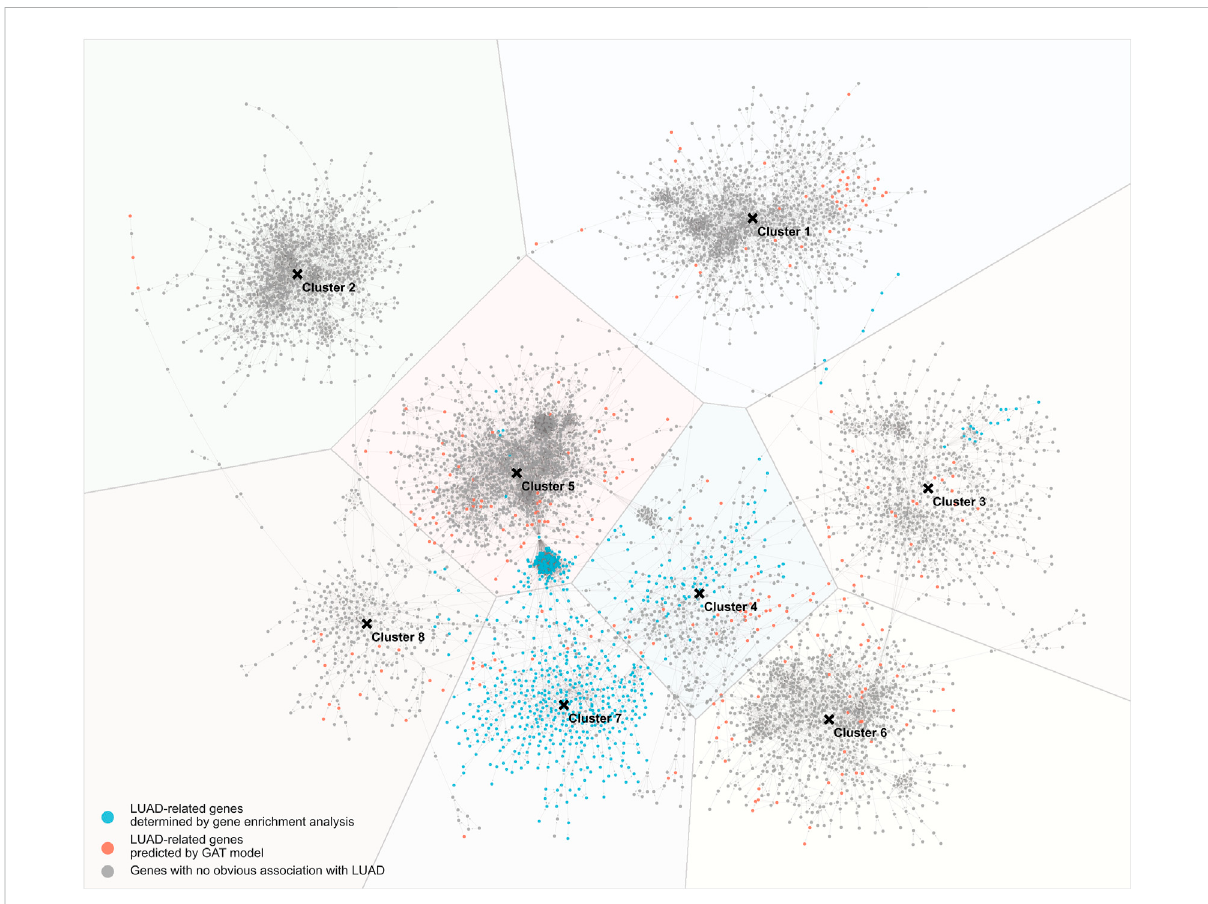
FIGURE 4 Gene-gene interaction network trained by GAT model. Blue nodes: LUAD-related genes determined by gene enrichment analysis; red nodes: LUAD-related genes predicted by GAT model; grey nodes: genes with no obvious association with LUAD.